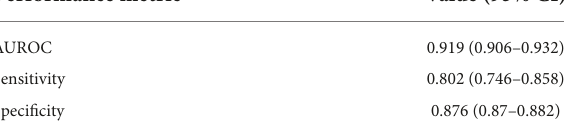
TABLE 2 Summary of algorithm performance